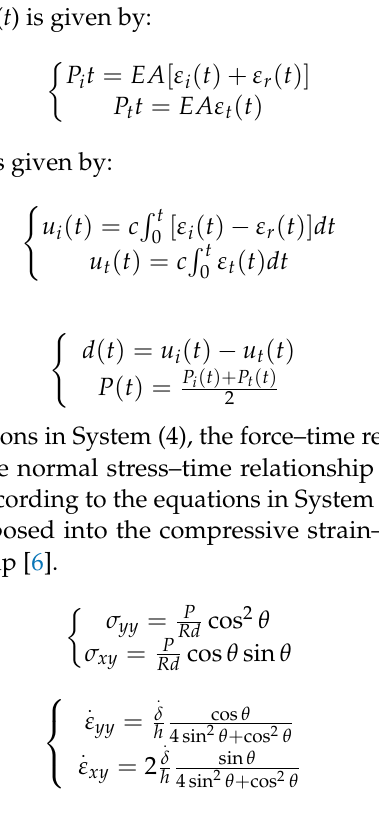
Figure 2. Experimental configuration diagram. Table 3. Experimental conditions of SHPB Loading.